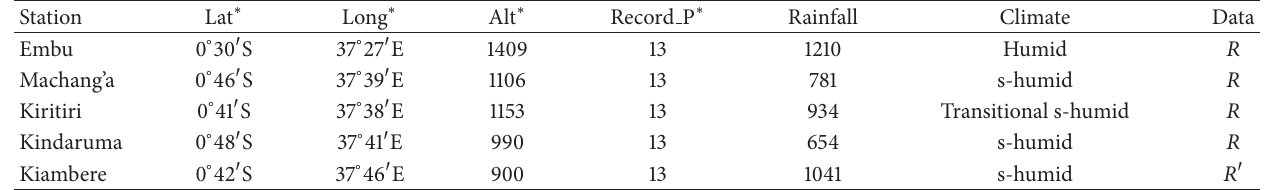
Table 1: Selected metadata of the meteorological stations used in the